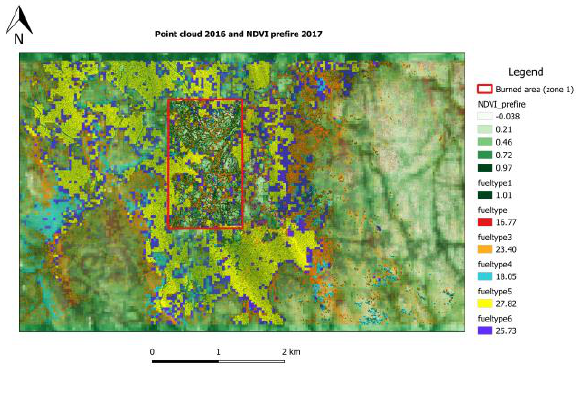
Figure 10. Comparation NDVI and Prometheus classification.